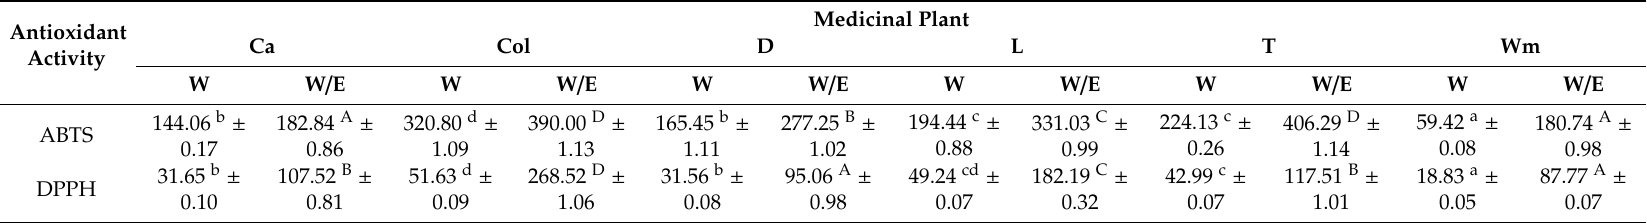
Table 2. Antioxidant activity determined with ABTS ( µ mol TE · g − 1 d.m.) and DPPH ( µ mol TE · g − 1 d.m.) assay in water and water-ethanolic extracts from medicinal plants.